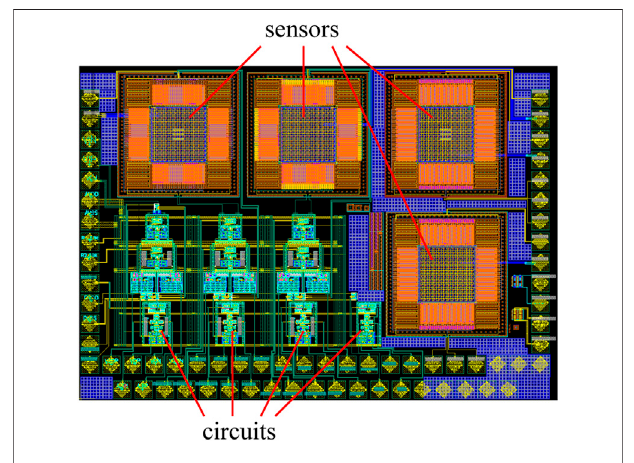
FIGURE 7 | Chip layout.